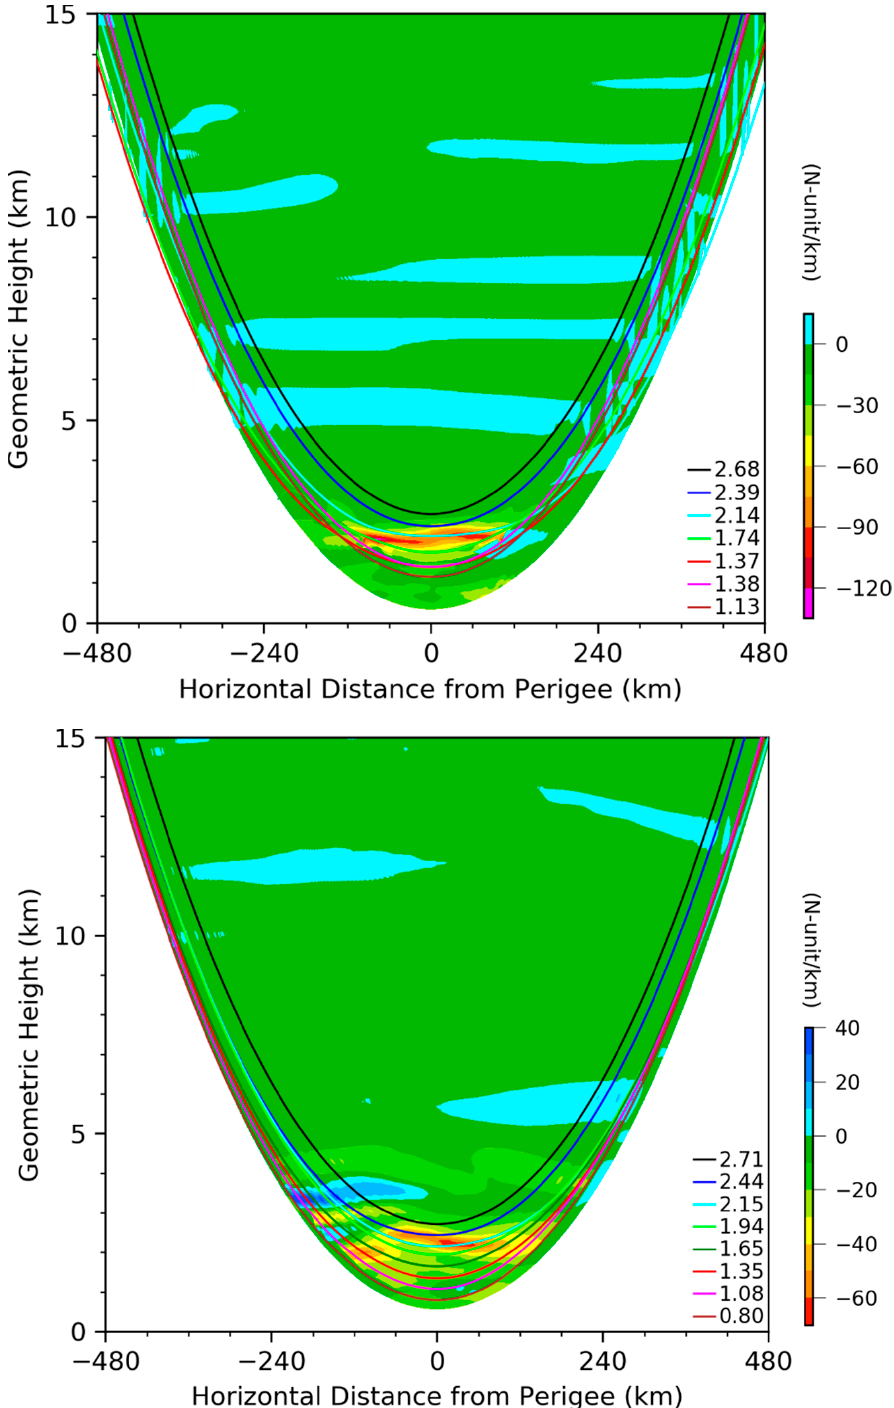
Figure 4. As in Figure 3 except for vertical gradients of N wet ( N -unit km − 1 , shaded in color) for RO1 ( top panel ) and RO2 ( bottom panel ). The geometric heights of the eight rays at the perigee points (in km) are indicated at the right-bottom corner of each figure.